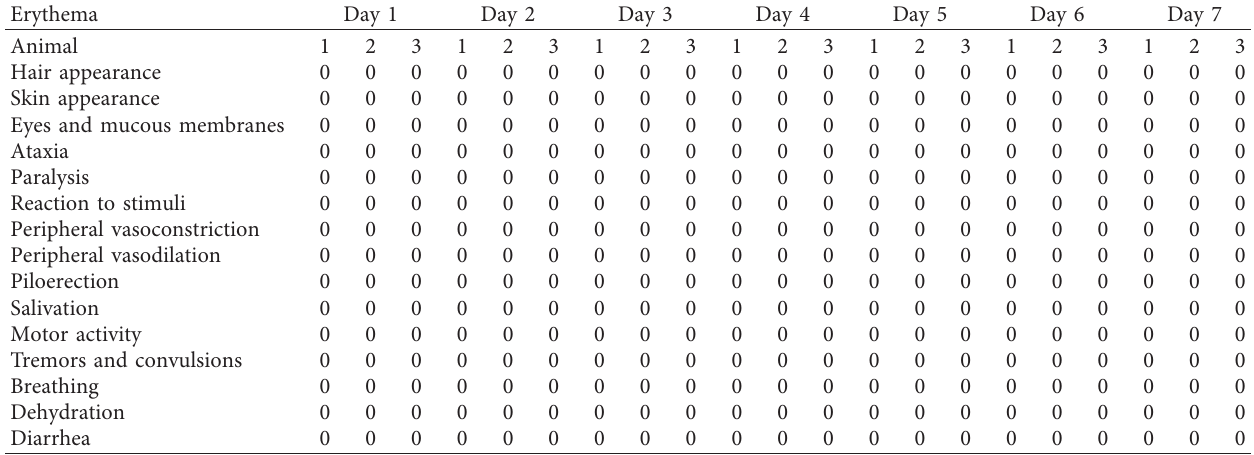
Table 7: Evaluation scale of dermal reactions (erythema and edema).